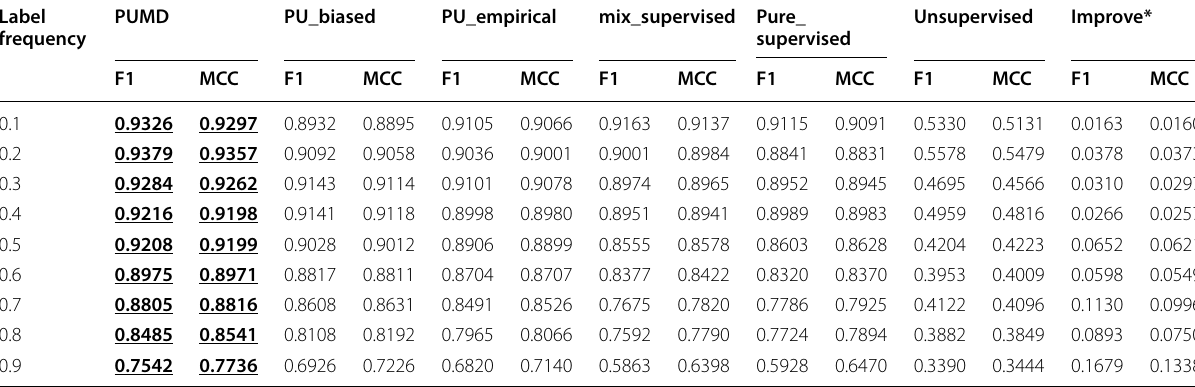
Table 11 PUMD and multiple comparison algorithms performance